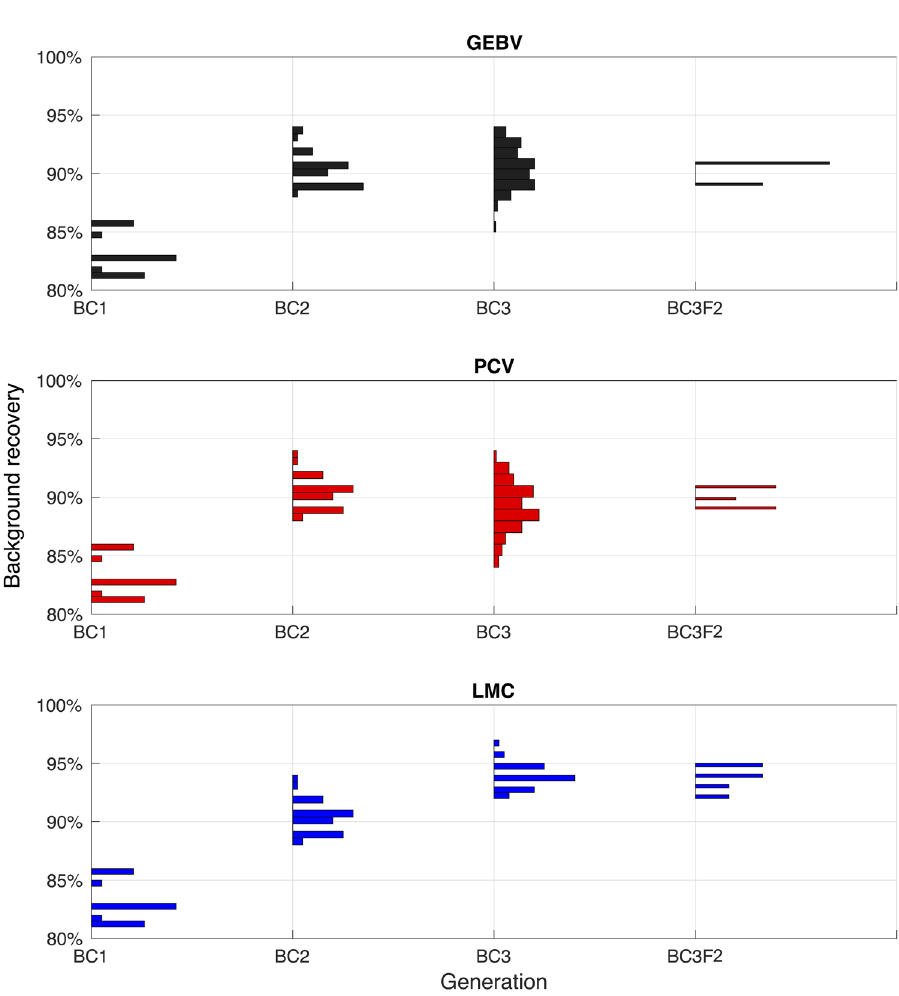
Figure 4. A sample simulation result for three different selection methods presenting histograms of population background recovery percentage over different generations. This simulation is performed for case 2, scenario